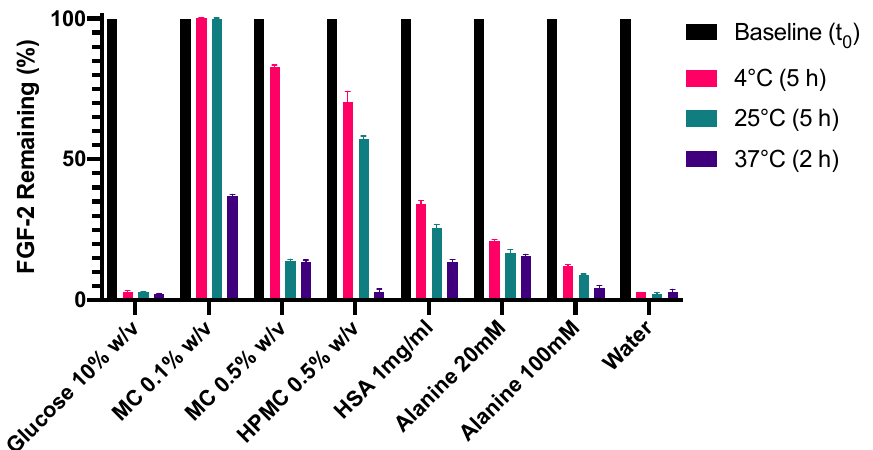
Figure 4. Effect of excipients on the stability of FGF-2 aqueous solutions (770 ng/mL) incubated at 4 °C for 5 h, 25 °C for 5 h and 37 °C for 2 h. Residual FGF-2 content following incubation was measured by ELISA and expressed as a percentage of the baseline concentration (mean ± SD, n = 3). Excipient abbreviations: methylcellulose, MC; hydroxypropyl methylcellulose, HPMC; and human serum albumin, HSA.